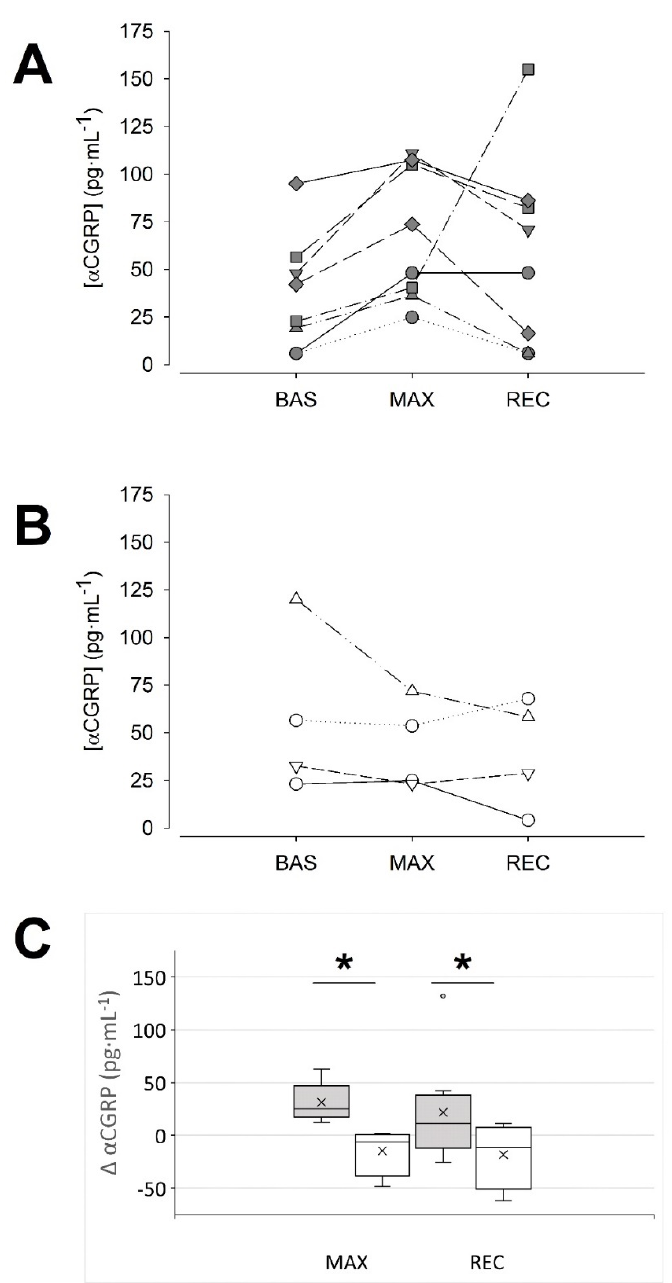
Figure 1. Two patterns of α CGRP response to maximal exercise could be identified. ( A ): data of the individuals that responded with an increase in their α CGRP concentration (‘responders’) at the maximal intensity. ( B ): data of the individuals in which blood α CGRP concentration was unaffected or tended to decrease at maximal intensity (‘non-responders’). ( C ): Absolute change of α CGRP concentration at the indicated condition vs. the BAS condition: dark grey boxes, ‘responders’, n = 8; white boxes, ‘non-responders’, n = 4; the cross represents the mean. * p < 0.05, two-way RM ANOVA. BAS: baseline; MAX: maximal effort; REC: recovery.